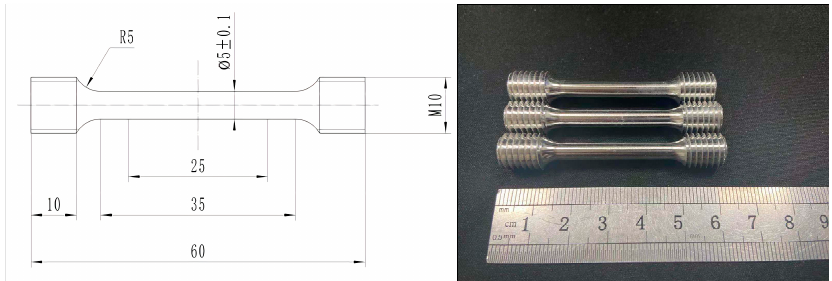
Figure 6. Schematic and physical diagram of dog-bone rod-shaped standard tensile specimen.